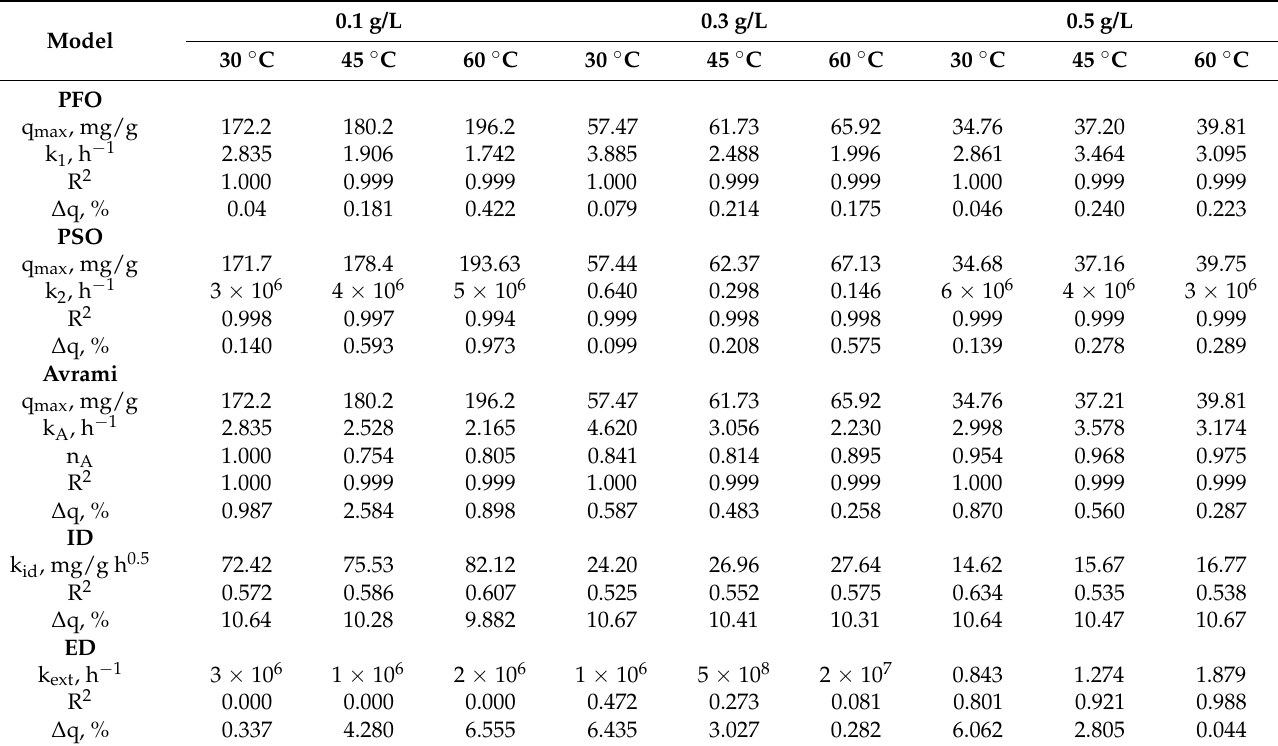
Table 8. Kinetic parameters for GV adsorption with WLW.